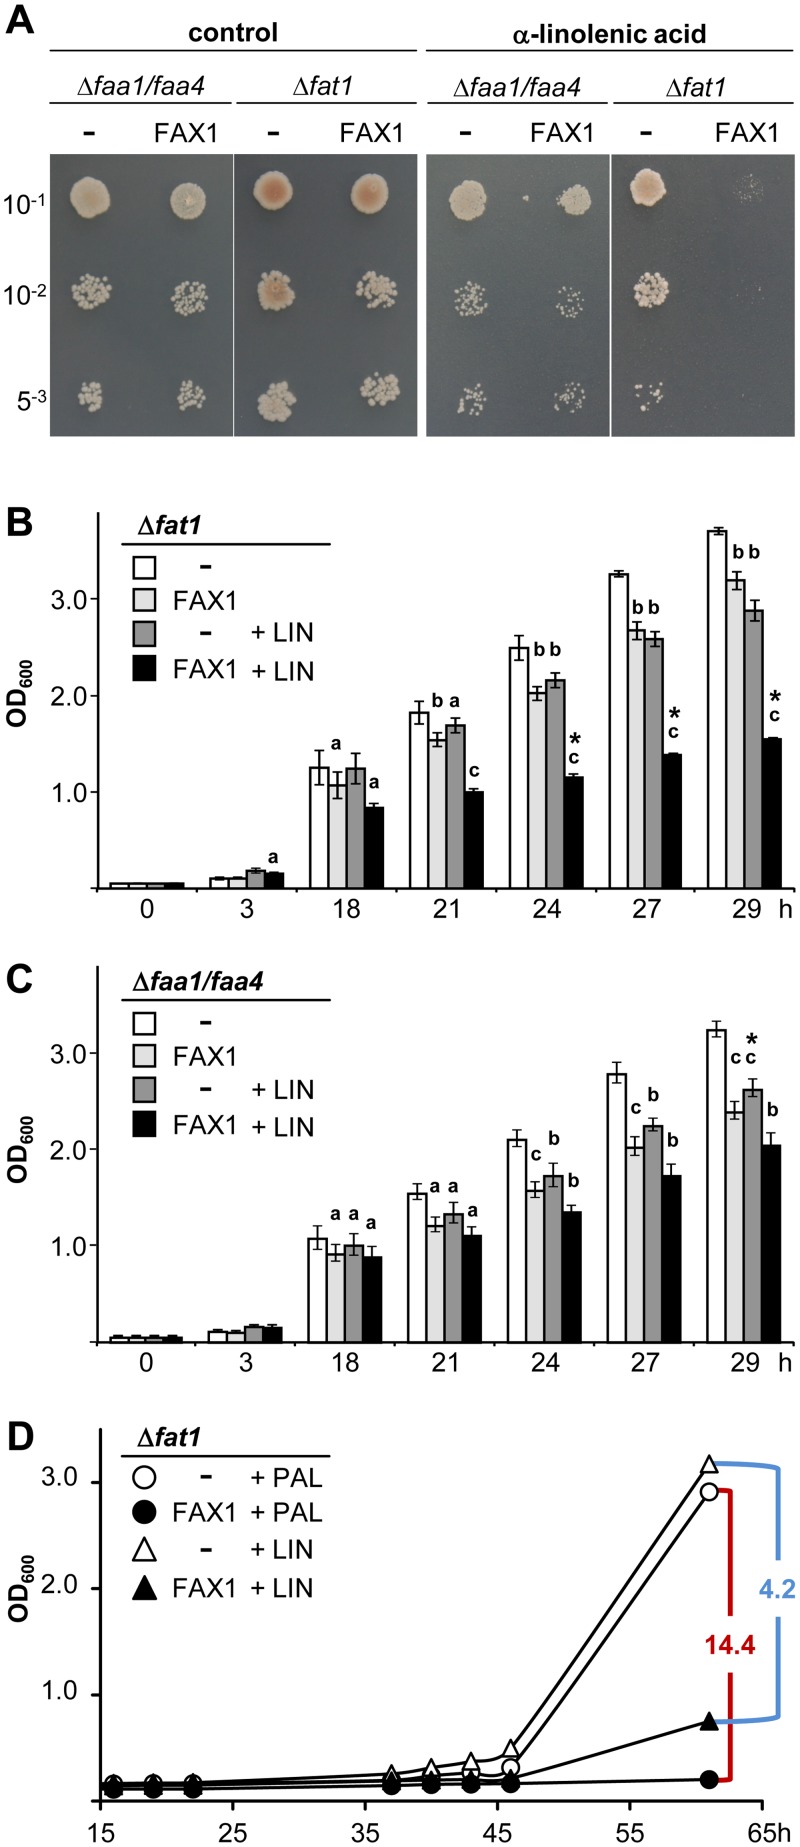
FAX1 mediates FA-transport in yeast.The empty plasmid pDR195 (-) and the mature At-FAX1 cDNA in pDR195 (FAX1) were introduced into faa1/faa4 and fat1 yeast mutants, respectively. (A) Serial dilutions (OD600 of 10–1, 10–2, and 5–3) of rapidly growing yeast cells on SD-ura plates (0.1% glucose, 1% tergitol). Control plates (left) in comparison to plates with 3.6 mM α-linolenic acid (C18:3; right). (B), (C) Growth of fat1 (B) and faa1/faa4 (C) cells in liquid SD-ura [see (A)]. The OD600 was monitored within 29 h incubation at 30°C. White and light gray bars: growth of pDR195 (-) and matFAX1/pDR195 (FAX1) at control conditions. Gray and black bars: growth of (-) and FAX1 in presence of 3.6 mM α-linolenic acid (LIN). Error bars depict SD (n = 4), for numerical values, see S1B Data. a (p < 0.05), b (p < 0.005), c (p < 0.0005), * (p < 0.00005) indicate significantly different values (Student’s t-test) compared to (-) cells without and with LIN, respectively. (D) Representative growth curves of fat1 cells in liquid SD-ura (2% glucose, 0.5% Brij 58, 0.7% KH2PO4) in the presence of 10μM cerulenin (CER, inhibitor of FA-biosynthesis) and 100 μM palmitic acid (PAL, C16:0) or 100 μM α-linolenic acid (LIN, C18:3). Assays were performed according to [26,27]. For comparison with stearic (C18:0) and oleic acid (C18:1), see S4 Fig. White and black circles and triangles: growth of pDR195 (-) and matFAX1/pDR195 (FAX1) cells supplemented with PAL and LIN, respectively. Red/blue lines and numbers indicate maximal difference of cell density ratios for (-) versus FAX1 (compare S1B Data).